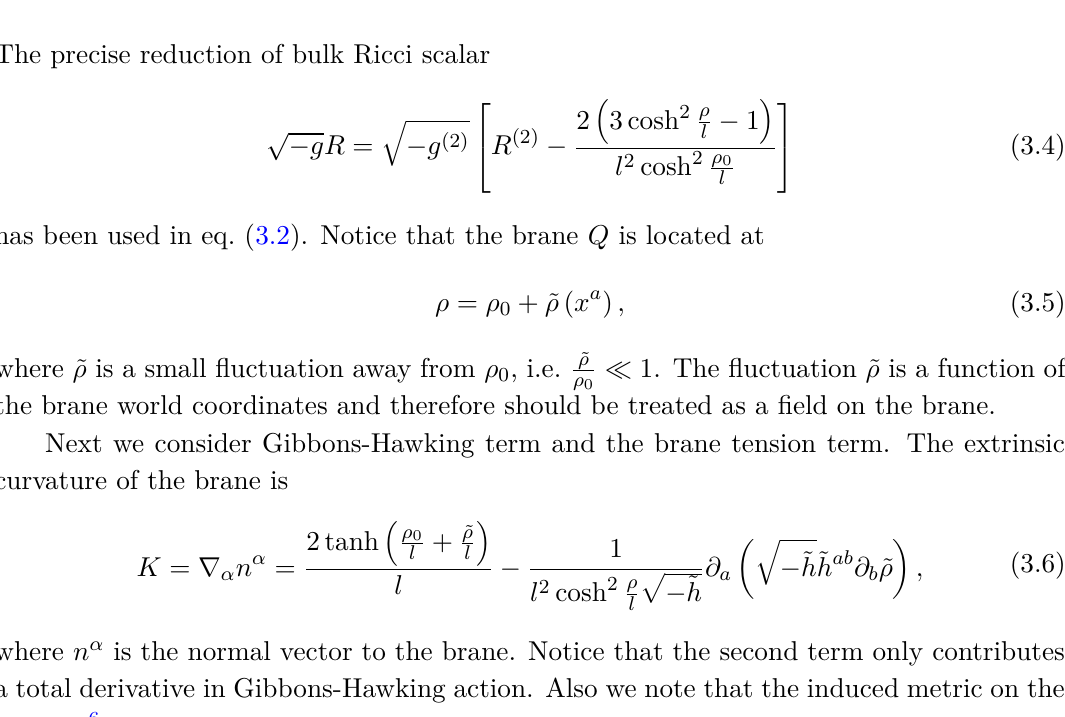
Figure 3 . Effective description from partial dimension reduction plus AdS/CFT where brane has small fluctuation in ρ